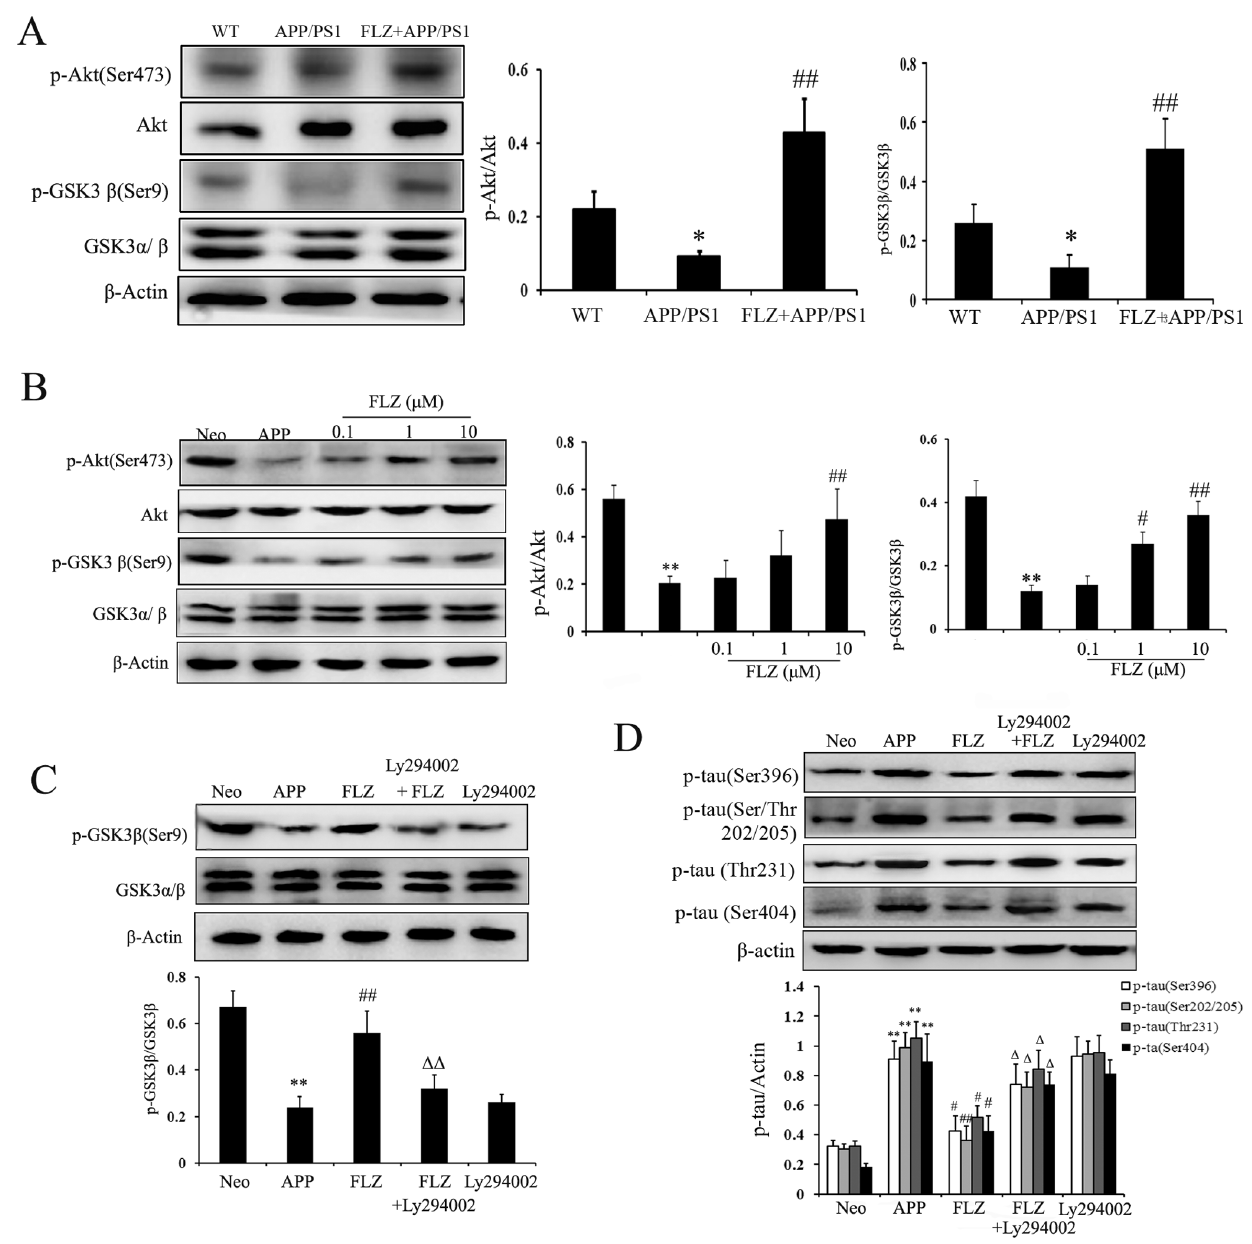
Figure 8. FLZ attenuated tau phosphorylation through regulating Akt/GSK3 b pathway. APP/PS1 double transgenic mice were orally treated with FLZ 150 mg/kg for 20 weeks. SH-SY5Y (APPwt/swe) cells were grown in ‘‘stimulating medium’’ containing 50% DMEM, 50% Opti-MEM, 0.5% FBS, 200 m g/ml G418 and 10 mM butyric acid sodium salt for 12 h to induce the transgene expression. FLZ (0.1, 1 and 10 m M), Ly294002 10 m M combined with FLZ 10 m M or alone were incubated with cells for 24 h. (A) Western blot assay of p-Akt (Ser473), Akt, GSK3 b and p-GSK3 b (Ser9) in hippocampus of APP/PS1 mice. A representative immunoblot from 4 mice was shown. Results were expressed as mean 6 SD. * P , 0.05 vs . WT mice; # P , 0.05, ## P , 0.01 vs . APP/PS1 mice. (B) Western blot assay of p-Akt (Ser473), Akt, GSK3 b and p-GSK3 b (Ser9) in SH-SY5Y (APPwt/swe) cells. A representative immunoblot from four independent experiments was shown. Results were expressed as mean 6 SD. ** P , 0.01 vs . Neo SH-SY5Y cells, # P , 0.05, ## P , 0.01 vs . solvent-treated SH-SY5Y (APPwt/swe) cells. (C,D) Ly294002 was added to test the effect of Akt on GSK3 b activity and tau phosphorylation in SH-SY5Y (APPwt/swe) cells treated with FLZ. A representative result of three independent experiments was shown. Results were expressed as mean 6 SD. ** P , 0.01 vs . Neo SH-SY5Y cells, # P , 0.05, ## P , 0.01 vs . solvent-treated SH-SY5Y (APPwt/swe) cells; D P , 0.05, DD P , 0.01 vs . FLZ-treated SH-SY5Y (APPwt/swe) cells. doi:10.1371/journal.pone.0078033.g008 evaluated by China FDA right now. To better understand the cause any changes of the mouse body weight and behavior. In our mechanism of FLZ’s neuroprotective effect, we applied FLZ on pre-clinical toxicity analysis, consecutive administration of FLZ to APP/PS1 transgenic mice and APP transgenic cells in the present rats for 30 days did not show any toxicity. Our data demonstrated study. The administration of FLZ lasted for 20 weeks and did not that FLZ attenuated A b production both in vitro and in vivo . APP is